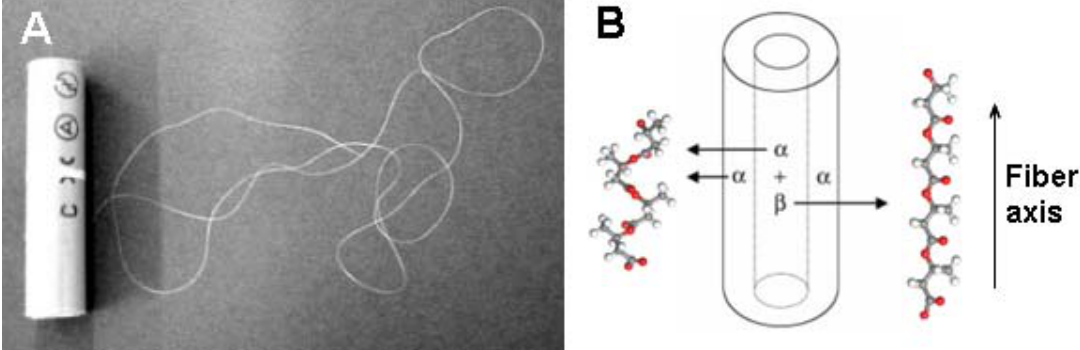
Figure 12. Cold-drawn annealed UHMW-P(3HB) fiber and schematic display of the core-sheath structure of P(3HB) monofilament with two kinds of